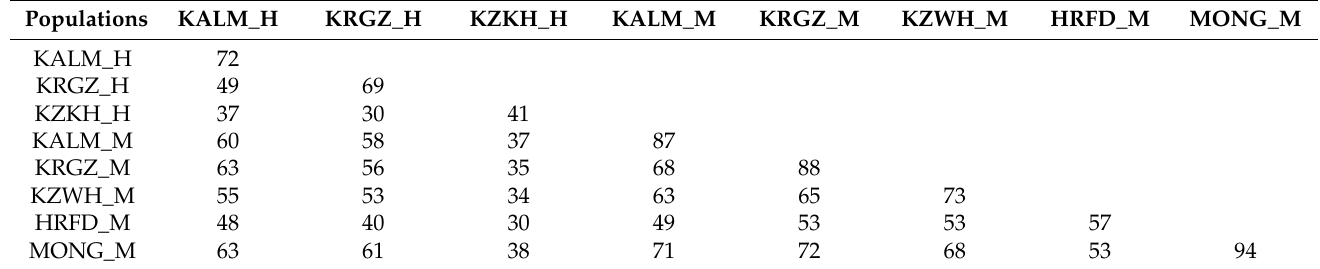
Table 2. Allelic variability and number of common alleles in studied breeds.